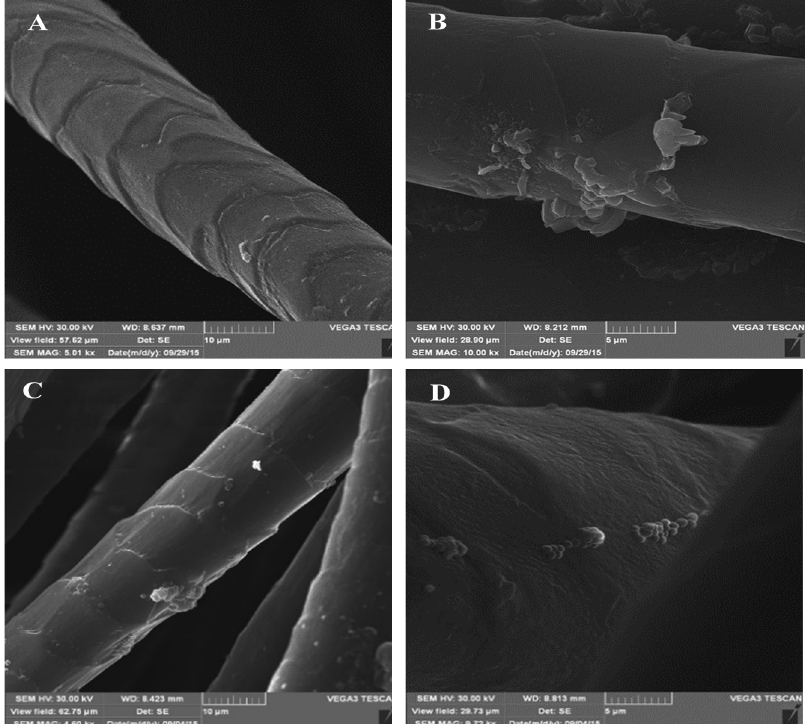
Figure 7. SEM pictures of wool fabrics dyed with 10% AB2 dye ( A and B ) and corresponding control samples of non-dyed wool fabrics ( C and D ) after 24-h incubation with the S. aureus strain.